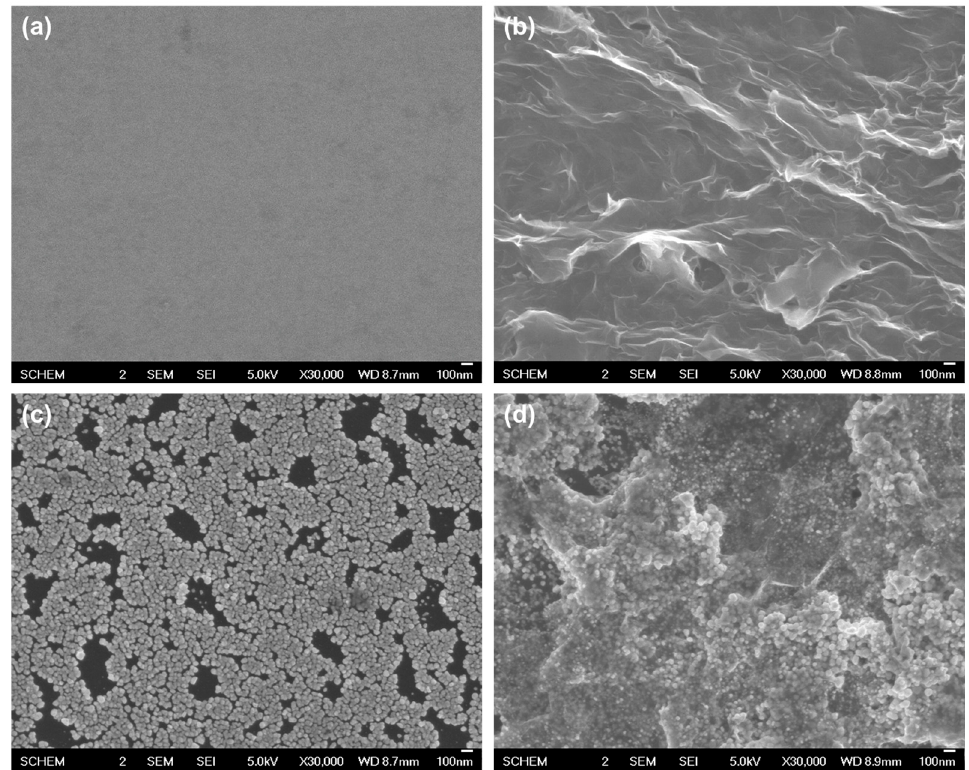
Nanomaterials 2017 , 8 , 17 Figure 2. SEM images of ( a ) bare GCE, ( b ) RGO-GCE, ( c ) AuNPs-GCE, and ( d ) RGO/AuNPs-GCE.